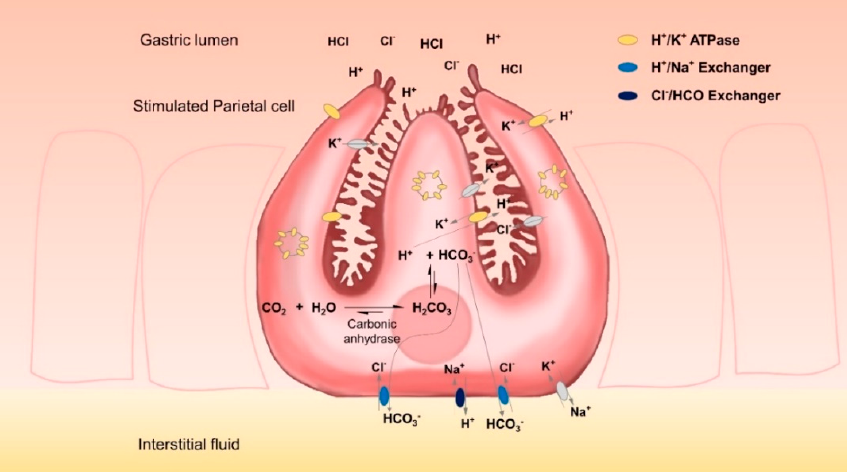
Figure 1. Schematic mechanism of proton secretion by HGT-1 cells. Carbonic anhydrases catalyze the reaction between CO 2 and H 2 O to form carbonic acid, which immediately dissociates into H + and HCO 3 − . H + ions are secreted in exchange of K + by H + /K + -ATPase antiporter pumps, of which the majority of these are located within the intracellular vesicles of unstimulated cells. In order to prevent intracellular alkalization, HCO 3 − ions are extruded by several members of the solute carrier (SLC) transport proteins in exchange of highly abundant extracellular ions. In addition to this, other exchangers might create an alkalinized microenvironment at the basolateral membrane level in order to enhance the activity of these extrusion